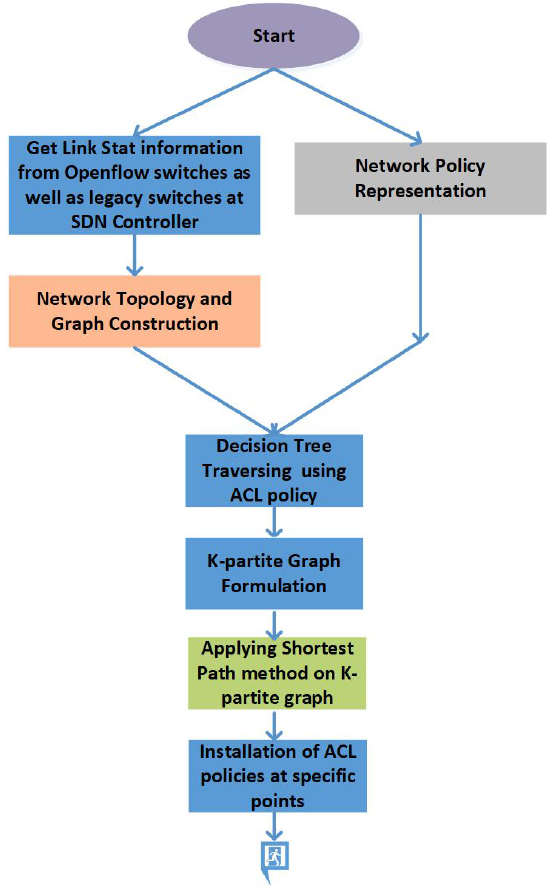
Figure 16. Flow Chart for proposed